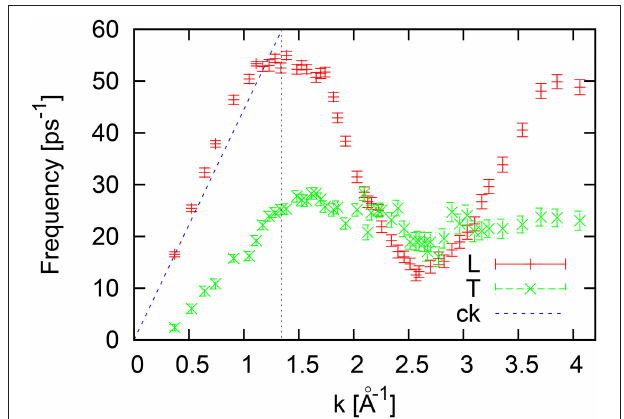
FIGURE 4 | Dispersion of logitudinal (L) and transverse (T) collective excitations for liquid Al at 1000 K estimated from peak positions of the L/T current spectral functions. The vertical dashed line at k = 1.345Å − 1 corresponds to the boundary of the first pseudo-Brillouin zone.